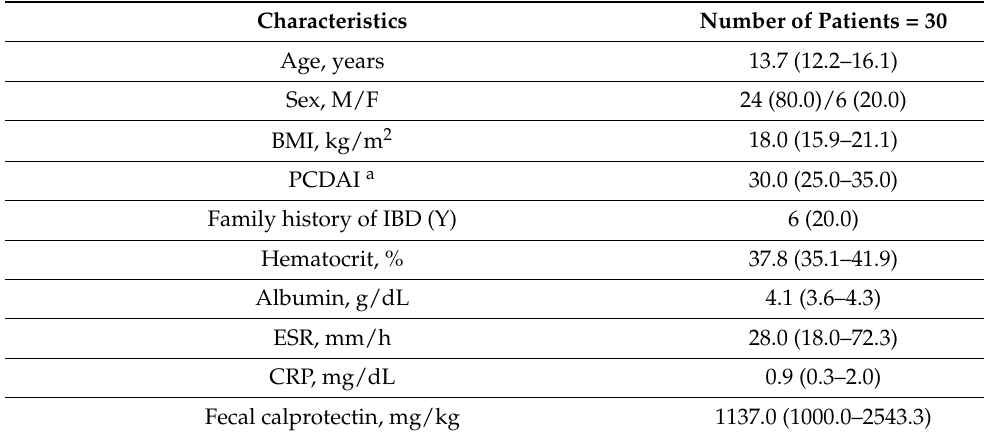
Table 1. Baseline patient characteristics at the initial diagnosis of Crohn’s